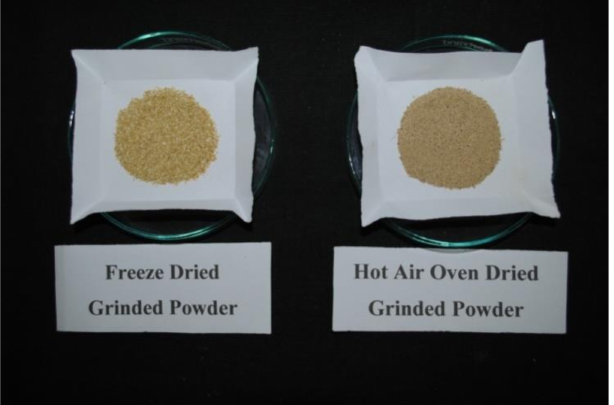
Figure 6. Freeze dried and hot air oven dried grinded powder of physiologically dropped immature mandarin ( Citrus reticulata Blanco)